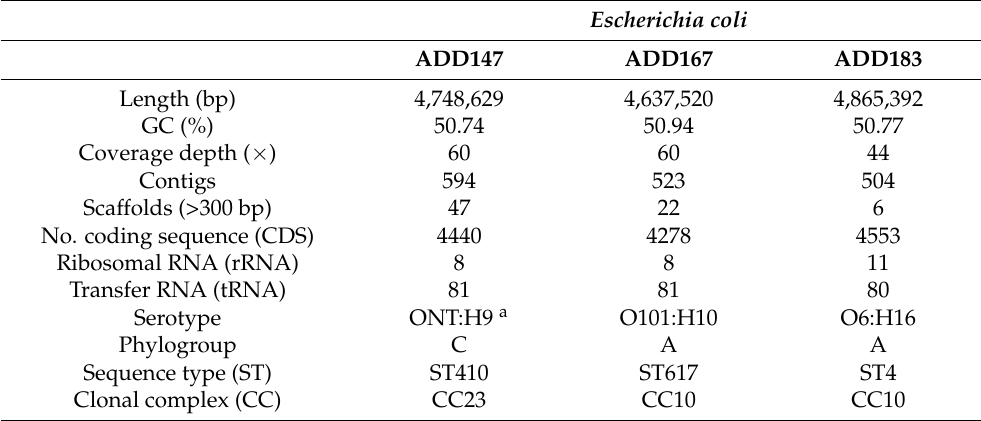
Table 1. General features of antibiotic-resistant E. coli genomes from surface water of agricultural drainage in northwestern